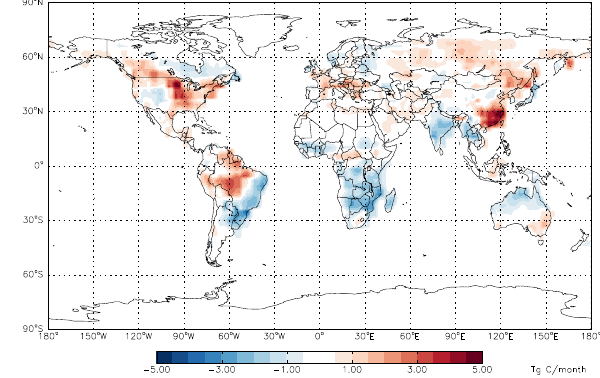
Fig. 3. Difference of spatial distribution between terrestrial ex- 11 change from CASA and fluxes from VEGAS in July